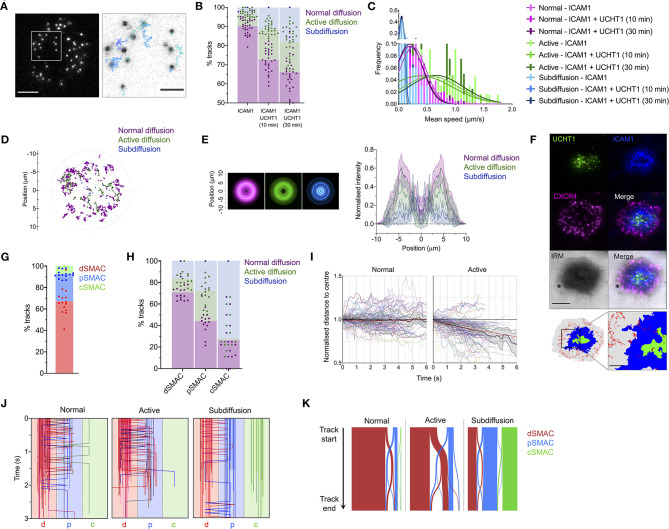
CXCR4 dynamics within the synapse. (A) Example of CXCR4-HaloTag single-particle tracking using TIRFM. The xy coordinates of all individual CXCR4-HaloTag spots were recorded every 50 ms and then linked together to derive particle tracks. (B) Proportion of single-particle CXCR4-HaloTag tracks exhibiting normal, active, or confined/subdiffusion in CD4+ blasts on inactivating or activating SLBs. Each point represents an individual cell. (C) Histogram of mean diffusion speed for tracks with different diffusive properties under activating and non-activating conditions. (D) Representative example showing relative location of different tracks within the synapse of a single cell. The entirety of all tracks over 30 frames in length are shown, centered around the approximate center of contact. (E) Radial averages of track locations across all cells imaged on activating SLBs (left), and cross-sectional normalized intensity profiles of those averages (right). Plots are mean normalized intensity at each position ± std dev. (F) Example of image partitioning based on IRM, ICAM1, and UCHT1 signals into d, p, and cSMAC regions, with single-particle tracks overlaid. (G) Proportion of all tracks that spend a minimum of three frames in the indicated regions. (H) Proportion of tracks exhibiting normal, active, or confined/subdiffusion in each indicated region. (I) Trajectories of 50 representative tracks undergoing normal or active diffusion, and mean ± 95% CL for all such tracks. Trajectories are expressed as normalized distance to center, in which the distance of the starting position of a track from the center of the imaged contact is given a value of one. Red lines indicate linear regression fit of all tracks. (J) Region position summaries of 50 example tracks for each diffusion type showing transitions between different regions of the synapse. Tracks are colored according to their starting region: red = dSMAC, blue = pSMAC, green = cSMAC. (K) Sankey plot summarizing starting region and transitions between regions for all recorded tracks. Bar width is proportional to the number of associated tracks within that diffusion category. All scale bars are 5 μm except for zoomed inserts (1 μm). All pooled data represent a minimum of n = 3 independent donors.